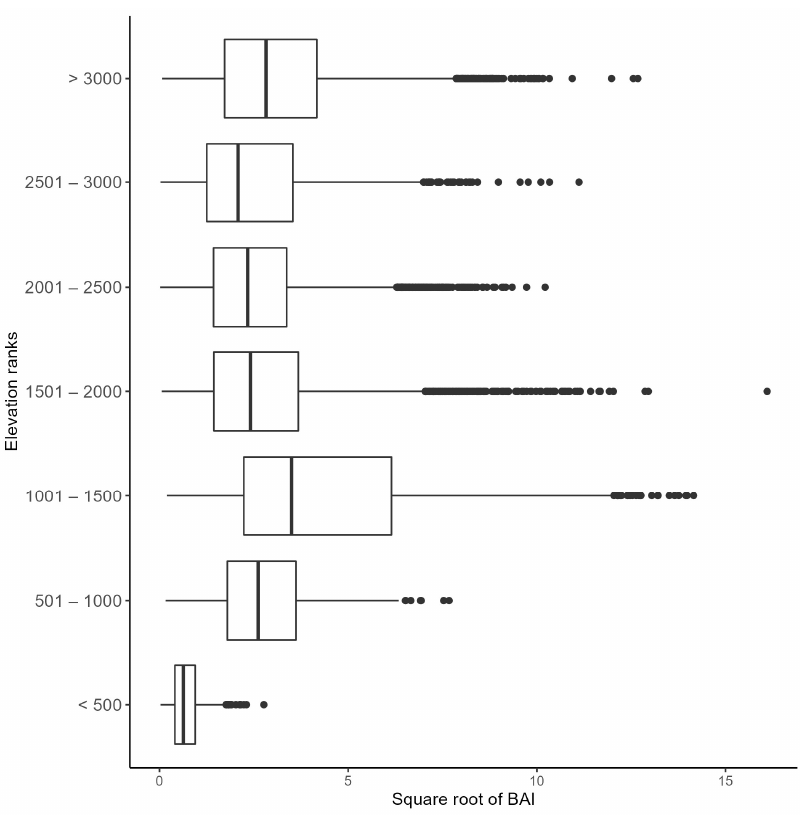
Figure 7. Basal area increment (BAI) (m 2 year −1 , x axis) of the twelve studied conifer species grouped according to elevation class (in meters, y axis).